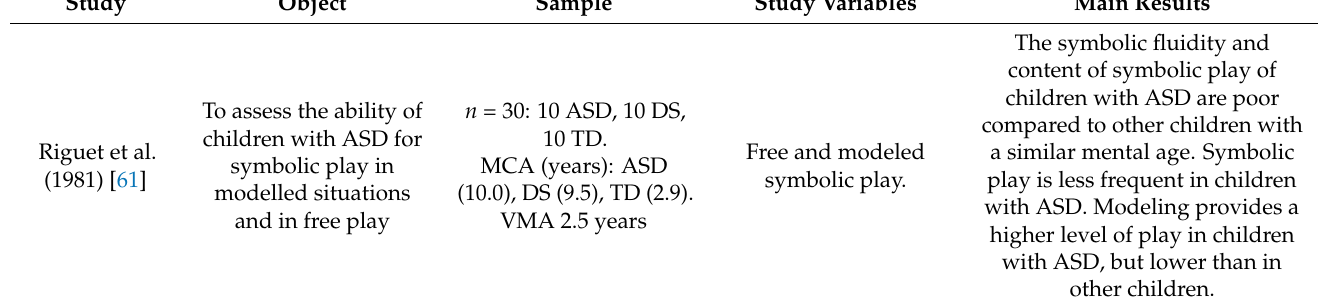
Table 1. Main characteristics of the studies analyzed in the scoping